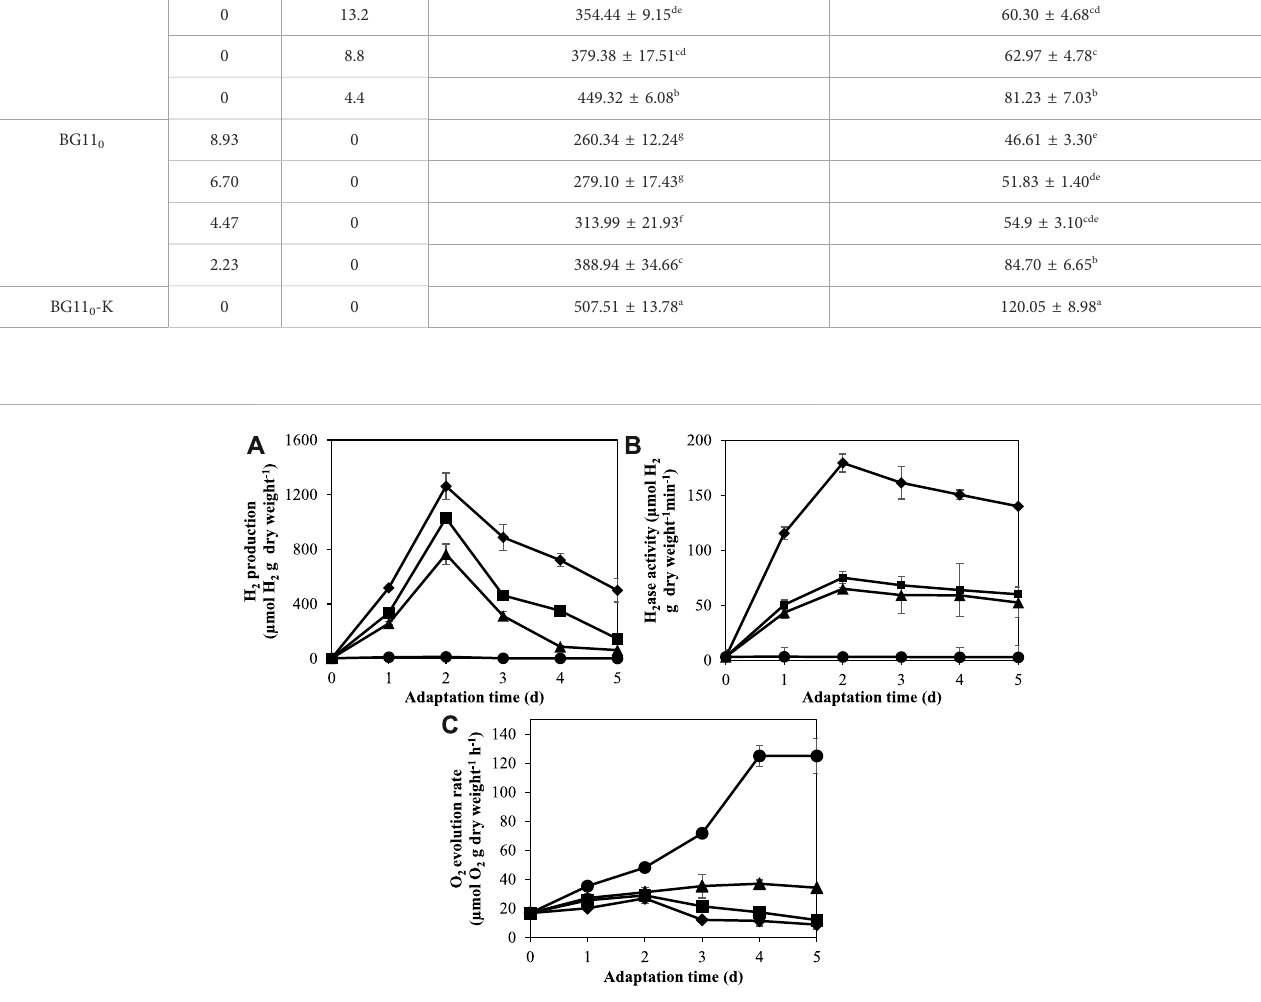
FIGURE 2 Effect of adaptation time on H 2 production (A) , H 2 ase activity (B) , and O 2 evolution rate (C) by A. halophytica cells. A. halophytica was adapted in various (cid:129) kinds of media for various times, BG11 ( ), BG11 0 ( ▲ ), BG11-K ( ■ ), and BG11 0 -K ( ⬧ ) for 1 – 5 days before harvesting and resuspending in a fresh medium. H 2 production was measured in incubated cells under dark anaerobic condition for 24 h. Data are means ± SD ( n =